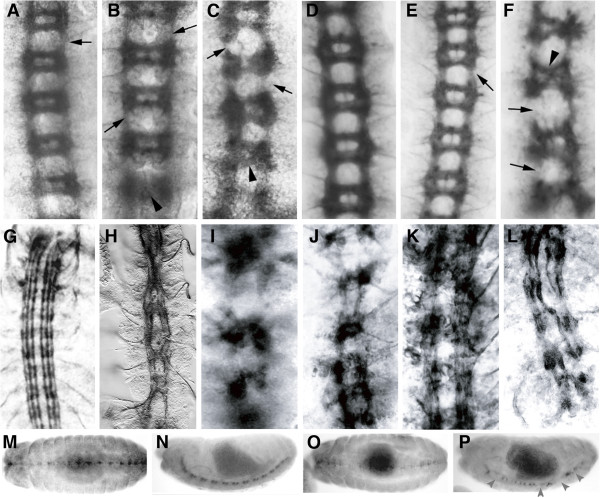
Dominant negative proteins mimic Dichaete phenotypes. A-F) BP102 staining reveals the ventral nerve cord of stage 16 embryos. All ventral views with anterior to the top. A) sim-GAL4;UAS-D; B) sim-GAL4;UAS-DΔHMG; C) sim-GAL4;UAS-DEnRep; D) pros-GAL4;UAS-D; E) pros-GAL4;UAS-DΔHMG; F) pros-GAL4;UAS-DEnRep. Arrows indicate breaks in the longitudinal connectives, arrowheads indicate collapse of commissures. G-L) FasII staining revealing the major longitudinal fascicles G) Wild type; H) Dr72/Df(3L)fz-GS1a; I) sim-GAL4;UAS-DΔHMG; J) sim-GAL4;UAS-DEnRep; K) sim-GAL4;UAS-mSox2ΔHMG; L) sim-GAL4;UAS-mSox2EnRep. M-P) Anti-Slit staining to reveal the midline glia. M and N) Wild type at stage 13 (M) and 15 (N). O and P) sim-GAL4;UAS-DΔHMG at stage 13 (O) and 15 (P). M and O are ventral views with anterior to the left, N and P are lateral views with anterior to the left. Grey arrowheads indicate loss of Slit expression.